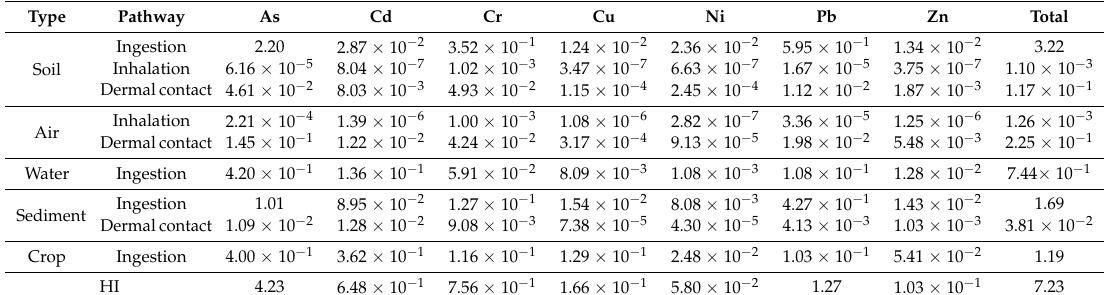
Table 7. The non-carcinogenic risk of trace metals for